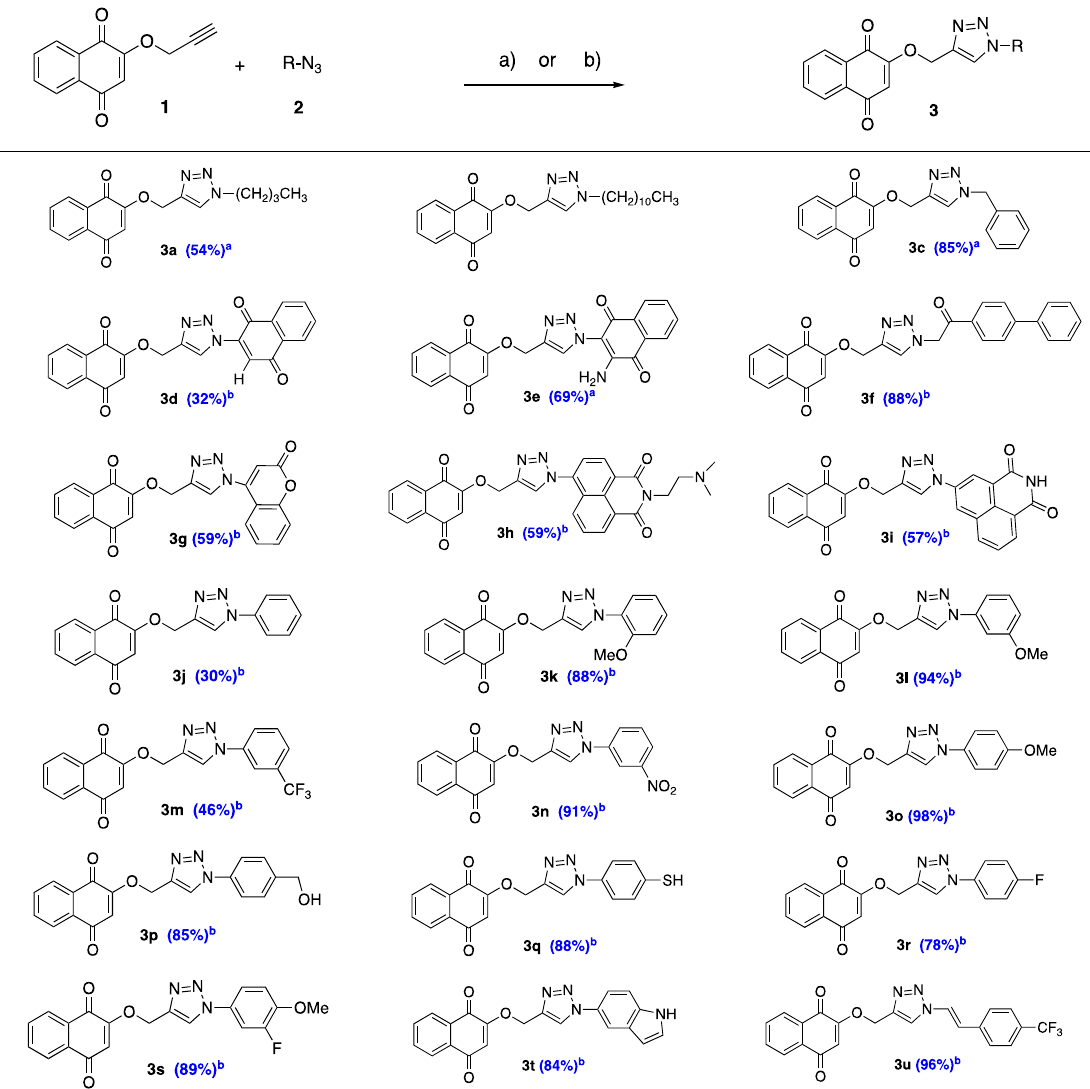
Table 1. Synthesis and structure of 1,2,3-triazole-naphthoquinones ( 3a–3u ).